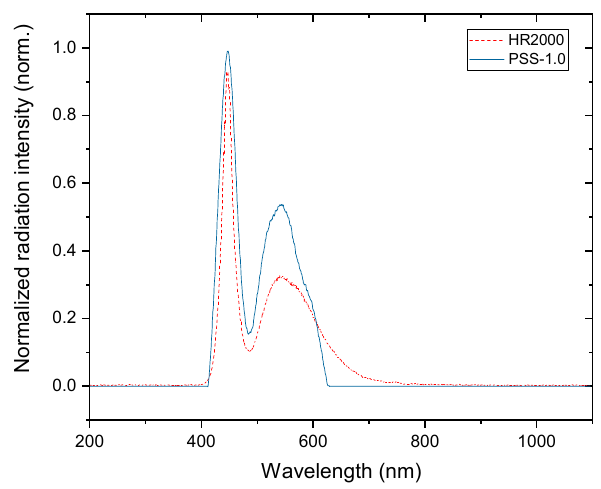
Figure 13. Spectrum of a white LED measured by the two different spectrometers.